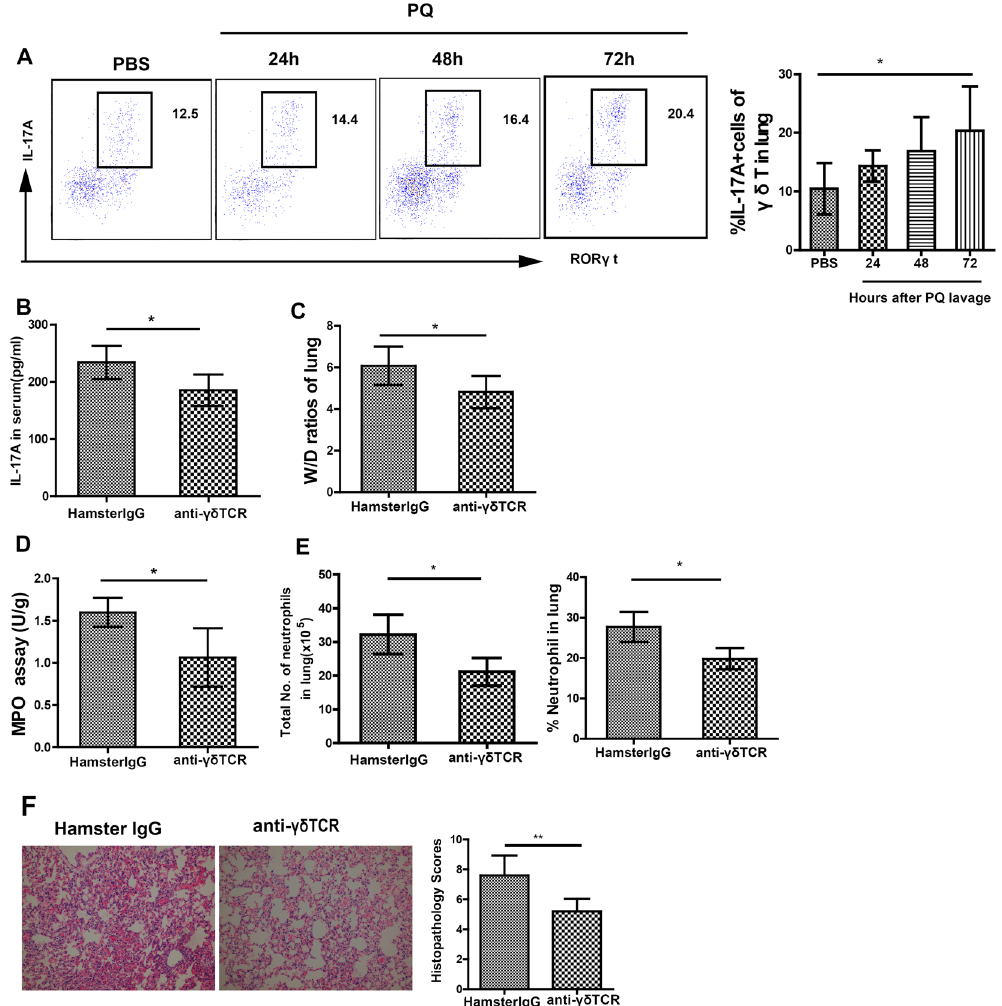
Figure 3. γδ T cells are a significant source for IL-17A production during PQ-induced ALI. ( A ) PQ poisoning significantly increased the percentage of IL17A + γδ T cells in the lung. Mice were intravenously injected with either anti- γδ TCR antibody for depleting endogenous γδ T cells (anti- γδ TCR; n = 6) or isotype-matched control IgG (hamster IgG; n = 6) two days before they received PQ gavage. At 72 h after PQ challenge, the mice were sacrificed and serum or lung tissues were collected. ( B–F ) Level of IL-17 in the serum ( B ), the W/D ratio ( C ), the MPO activity ( D ), the number and percentage of lung-infiltrating neutrophils ( E ), and the histopathology score (200 × ; ( F ) were significantly lower in anti- γδ TCR group than in the control hamster IgG group. All data are presented as mean ± SD for all mice in each group and compared between the PQ- and PBS-challenged mice ( A ) or between the anti- γδ TCR- and hamster IgG-injected mice (B to F). * P < 0.05 and ** P <